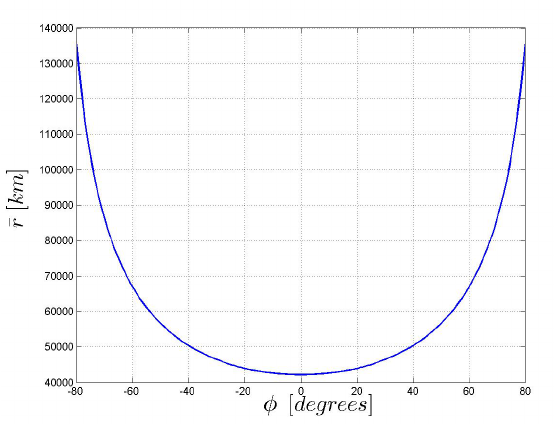
Figure 3: The figure shows the mean geocentric radius (¯ r ) along parallel circles of the zero gravity surface between ±80 ∘ latitudes.